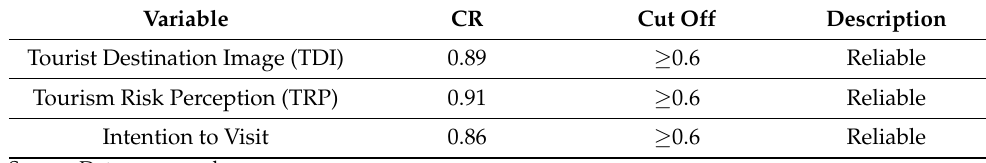
Table 6. Reliability Test Results.